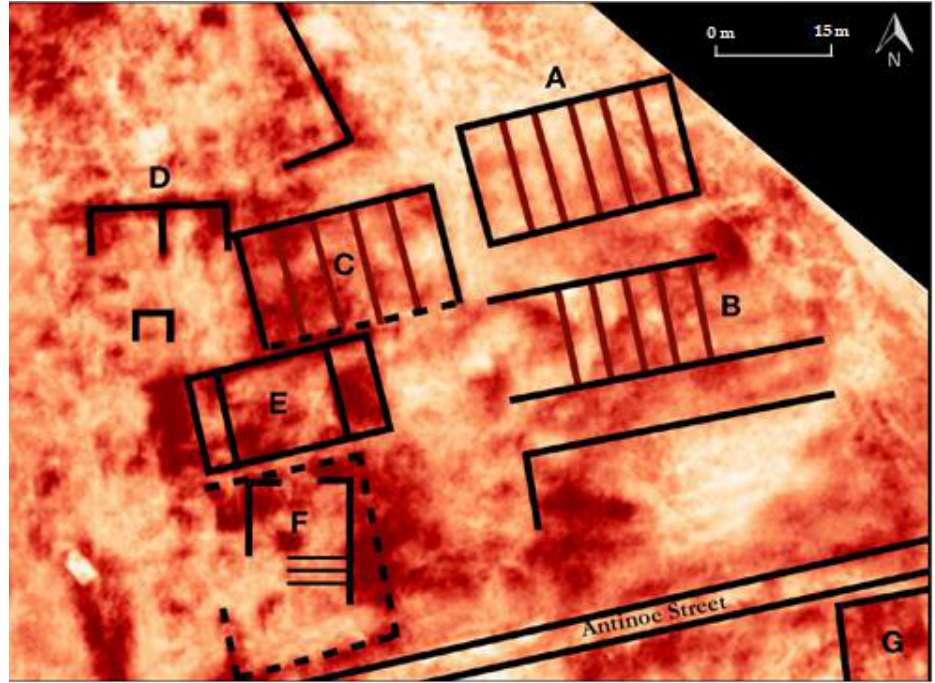
Figure 7. Seven structures (Installations A – G ) that were mapped from IPVI spectral analysis. Instal- lations A – C are believed to have had storage funcitonality. Note: solid lines indicate linear features that are clearly visible, whereas dotted lines indicate partial features.